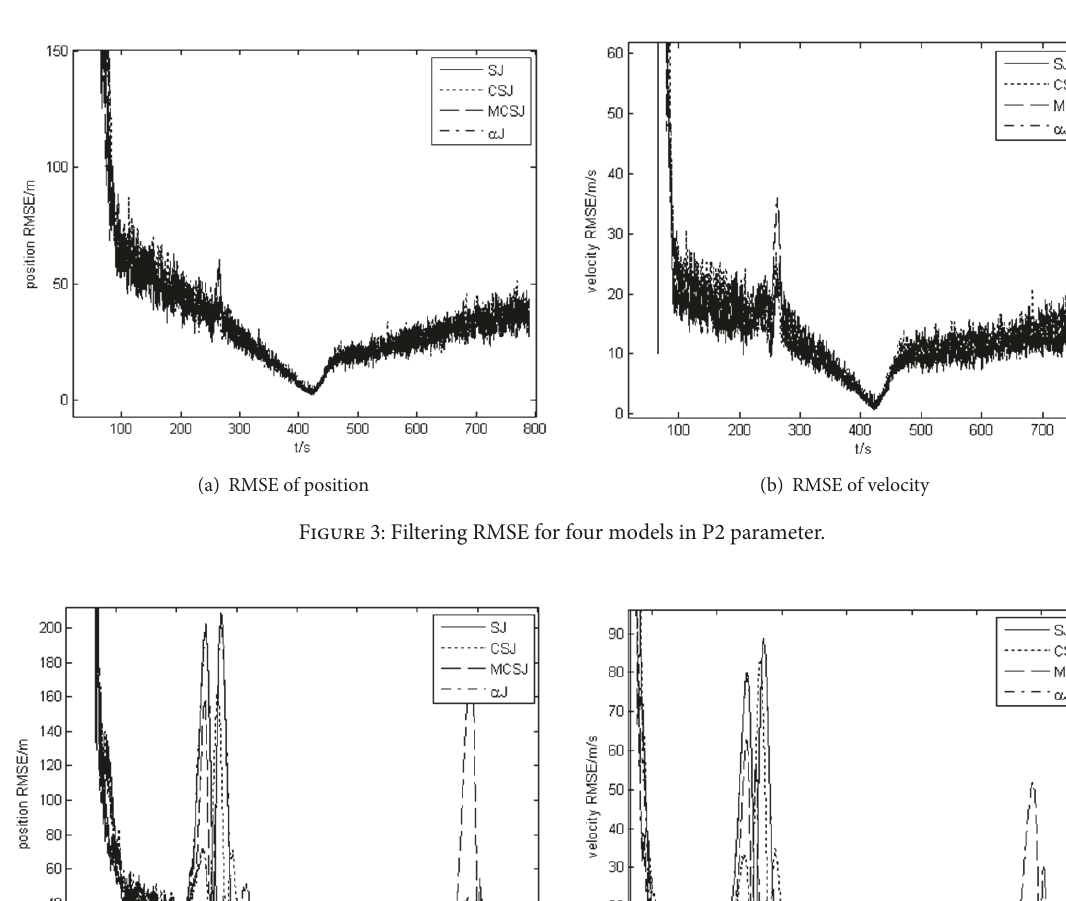
Figure 2: Filtering RMSE for four models in P1 parameter.